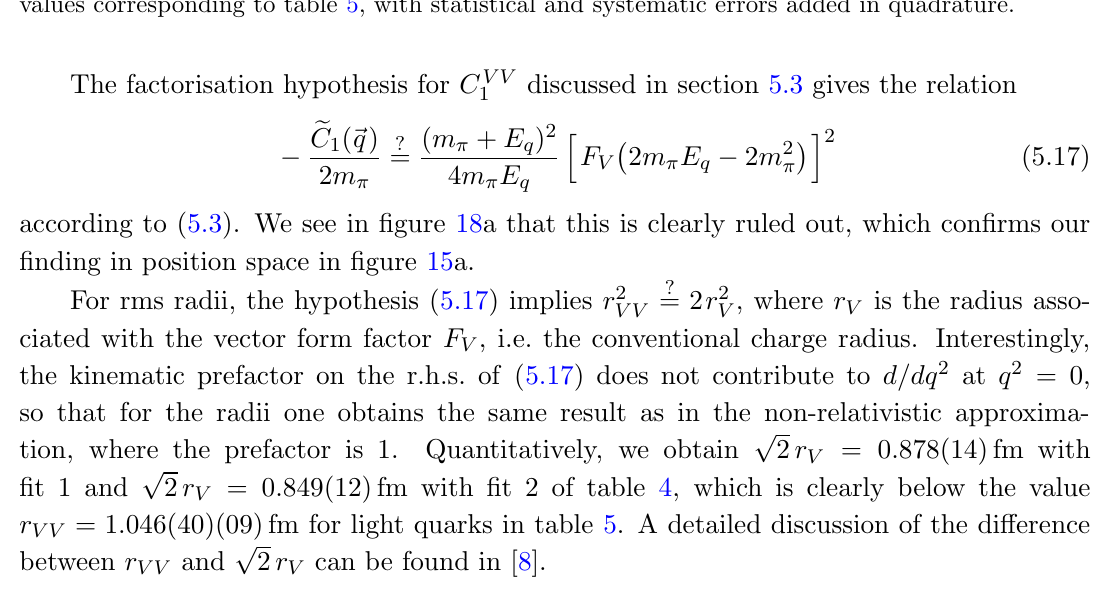
Figure 19. Squared rms radii r 2 extracted from (cid:12)tting e C 1 to the form (5.16) in the interval 0 q 2 q 2 , together with their jackknife errors. The entries labelled \avg" give the averaged max (cid:20) (cid:20) values corresponding to table 5, with statistical and systematic errors added in